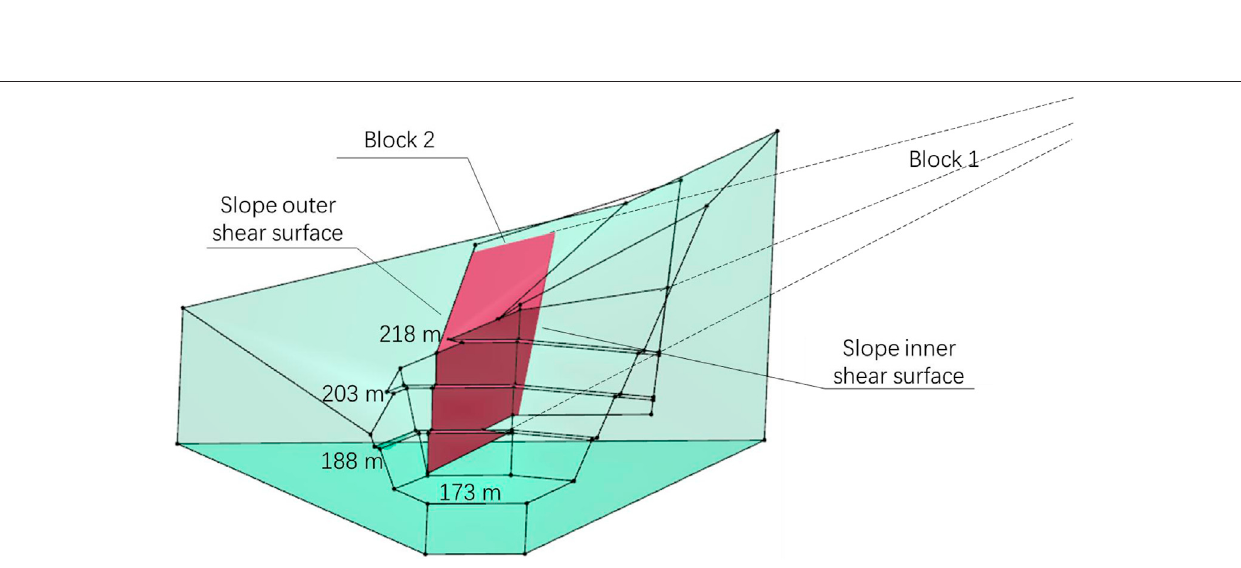
Frontiers in Earth Science |